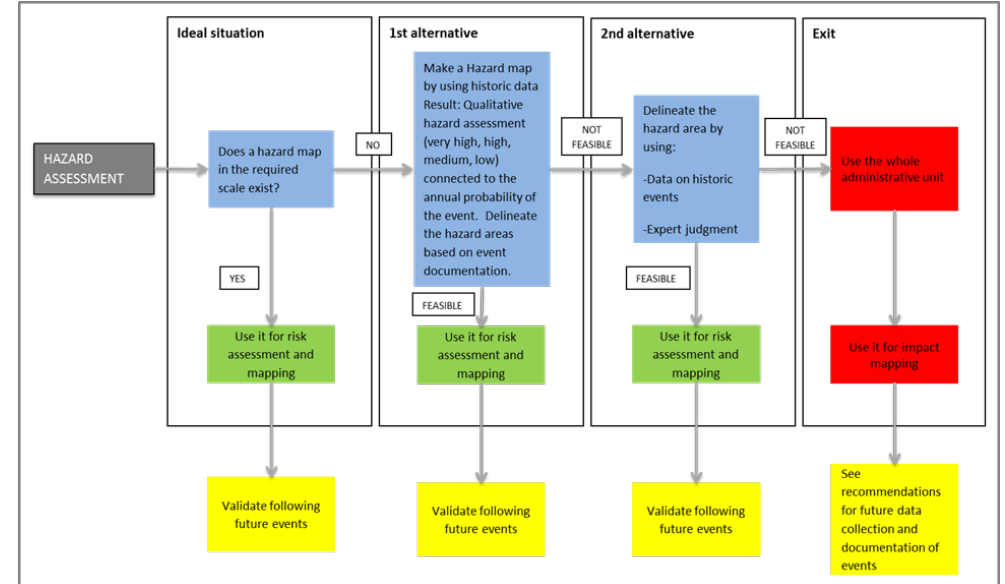
Figure 5. Qualitative hazard assessment using alternative steps [46].